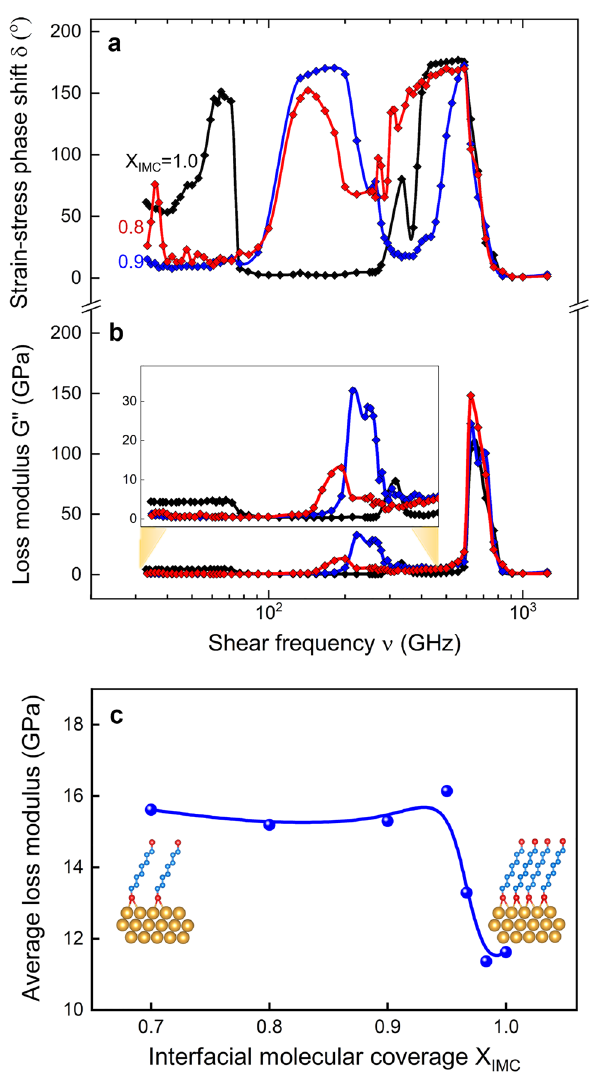
Figure 3. Viscoelastic damping characteristics in Au/octanedithiol MNL/Au multilayers for different interfacial molecular coverages X IMC . (a ) Strain–stress phase shift δ and ( b ) loss modulus G’’ as a function of shear frequency, ( c ) frequency-averaged G’’ as function of X IMC